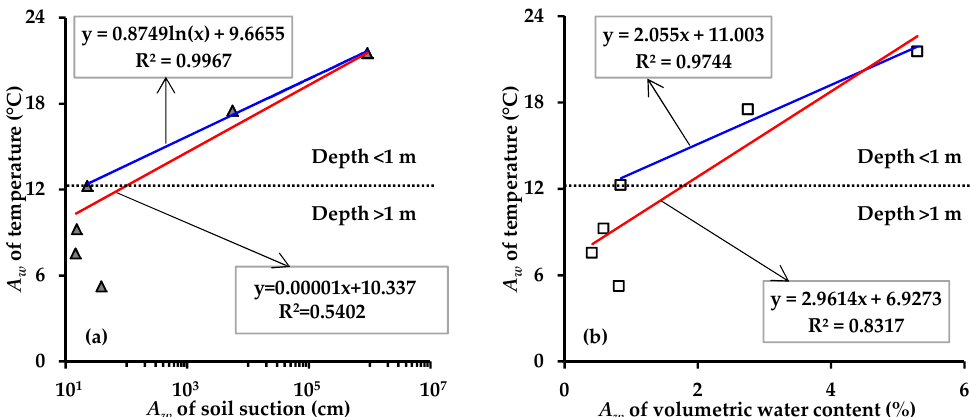
Figure 5. The relationship plots for fluctuation amplitudes of different factors in the shallow vadose